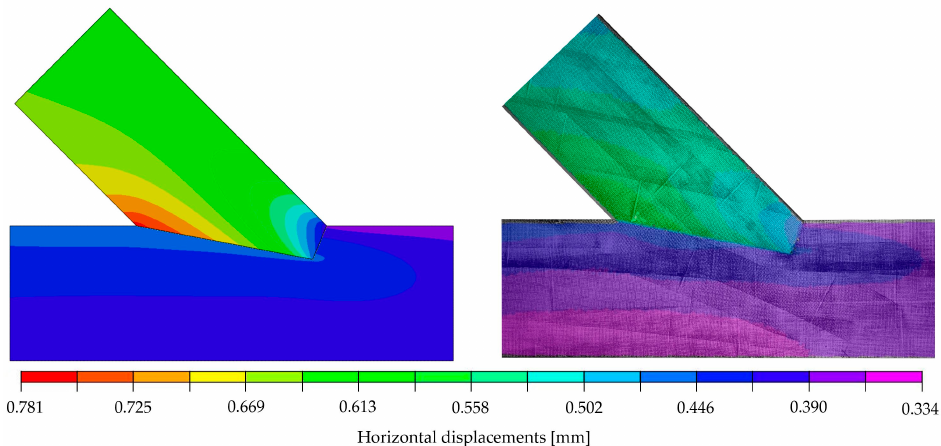
Figure 12. ( Left ): Horizontal displacements of the numerical model at a load of 29.6 kN; ( Right ): DIC-horizontal displacements on the surface of specimen A_5 at 70.1 kN with the initial picture at 40.5 kN (representing a load step of approximately 29.6 kN).